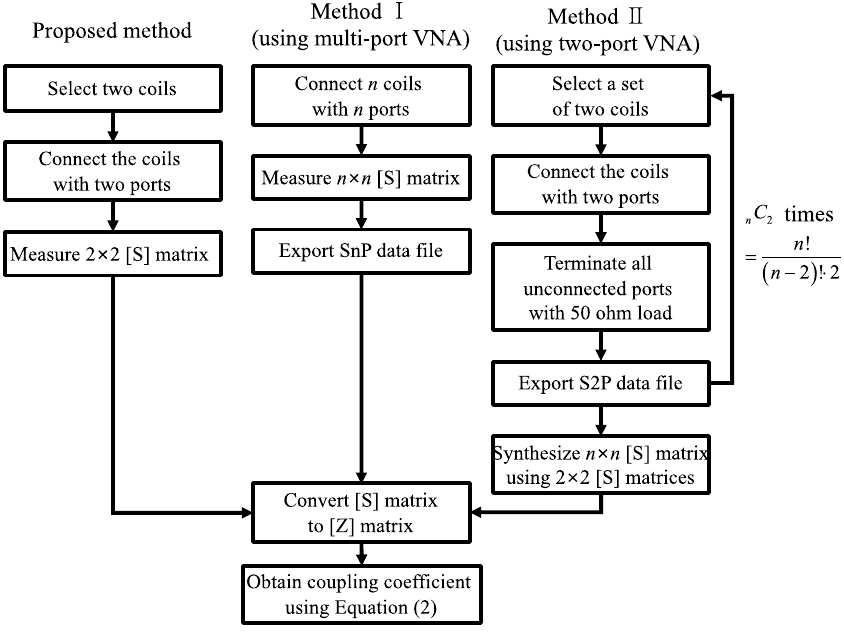
Figure 4. Measurement procedures for the proposed and conventional methods.